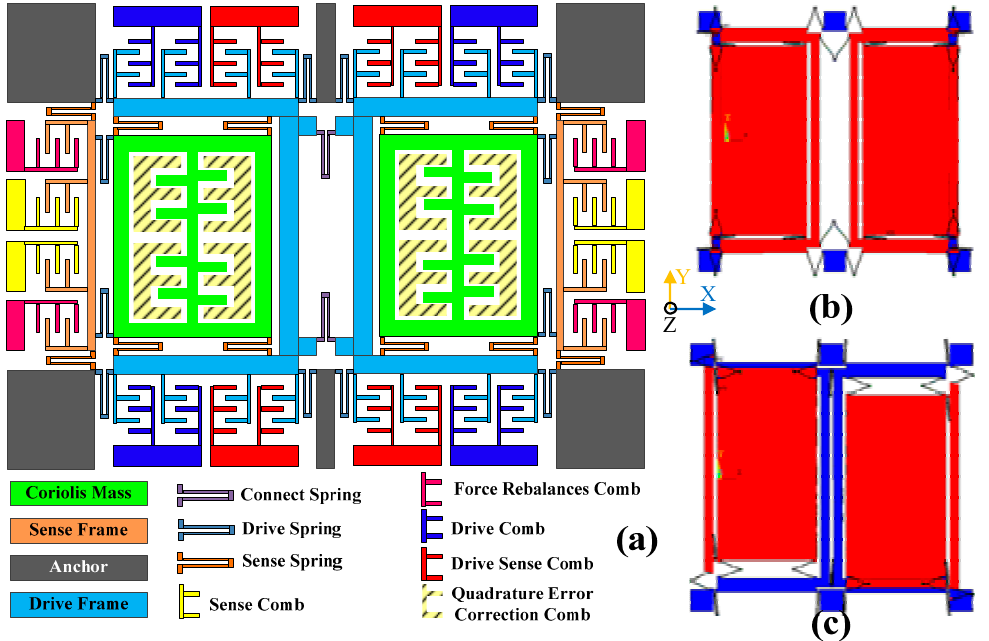
Figure 1. ( a ) Schematic and part photos of dual-mass gyroscope structure; ( b ) Drive anti-phase mode simulation; ( c ) Sense anti-phase mode simulation.